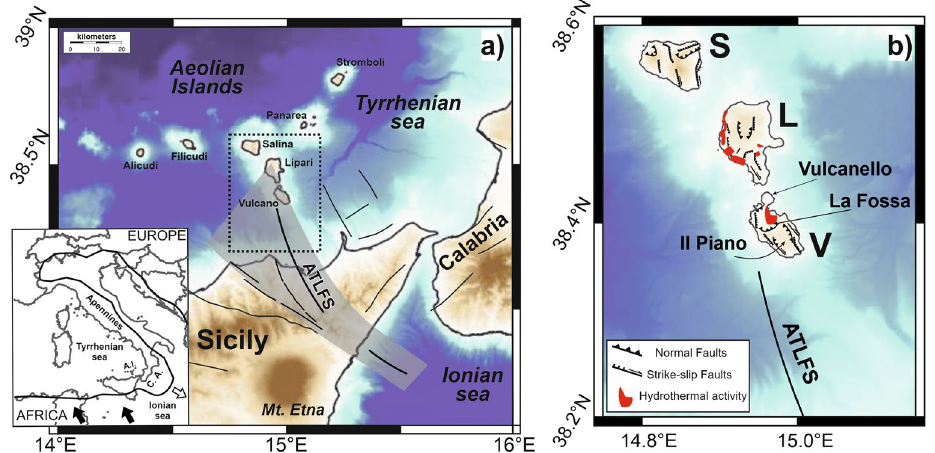
Figure 1. ( a ) Map view of the Southern Tyrrhenian region showing the area including northern Sicily, southern Calabria and the Aeolian Islands onto a simplified representation of the main fault systems. The gray belt highlights the Aeolian Tindari-Letojanni Fault System (ATLFS); the dashed rectangle encloses the area of main interest of this paper. In the inset, a geodynamic sketch of the central Mediterranean region: black arrows indicate the present-day motion of Africa with respect to Europe (according to Ref. 12 and references therein); the white arrow indicates the orientation of the gravity-induced rollback of the Ionian subducting slab. C.A. and A.I. stand for Calabrian Arc and Aeolian Islands, respectively. Bathymetric data have been downloaded